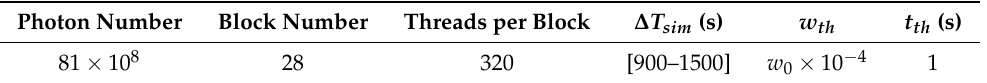
Table 6. Technical characteristics of the GPU-based parallel computing and MC simulation